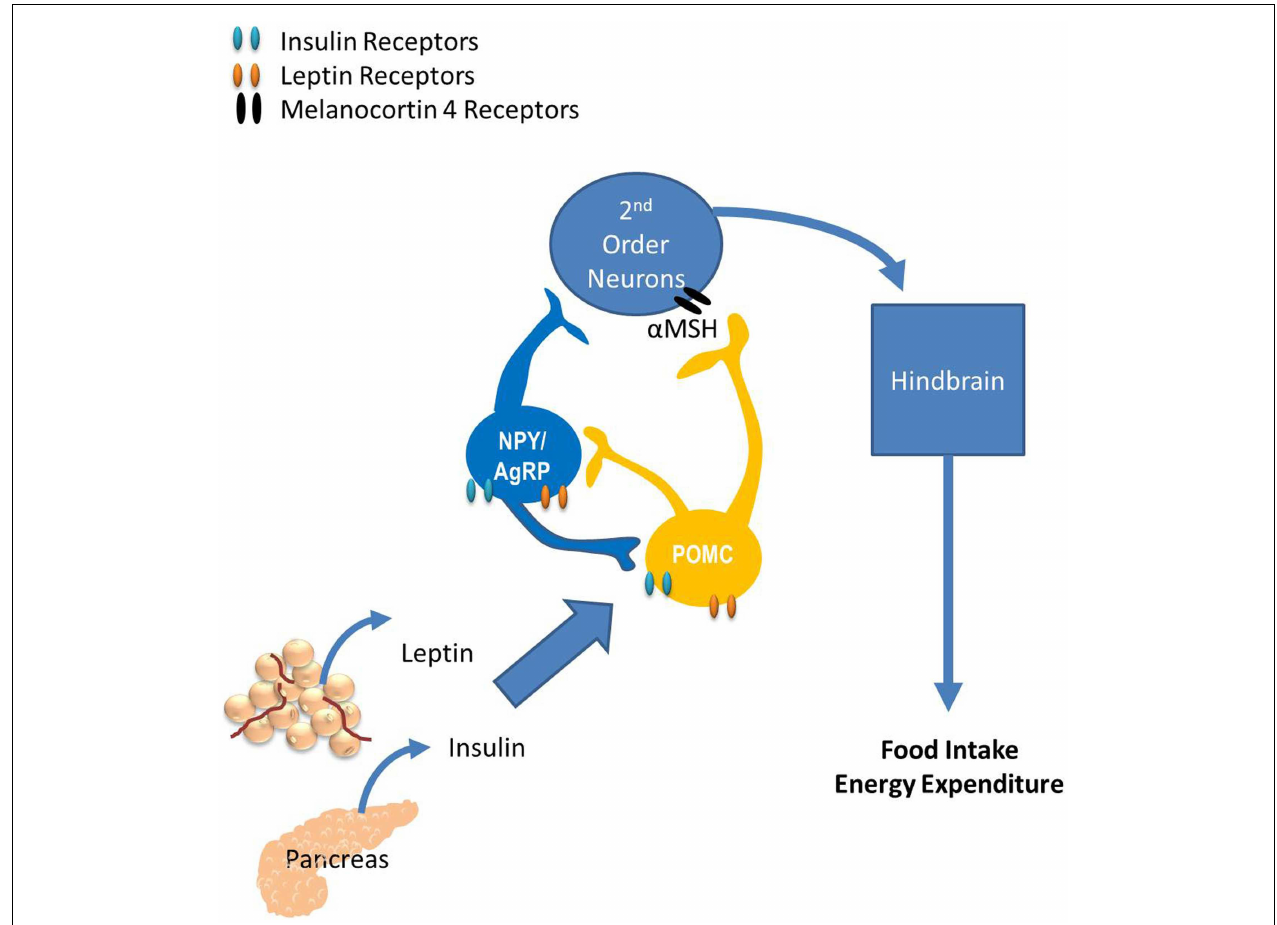
hypothalamus. Subsequently, these neurons project to the hindbrain and the periphery, providing a route of communication between